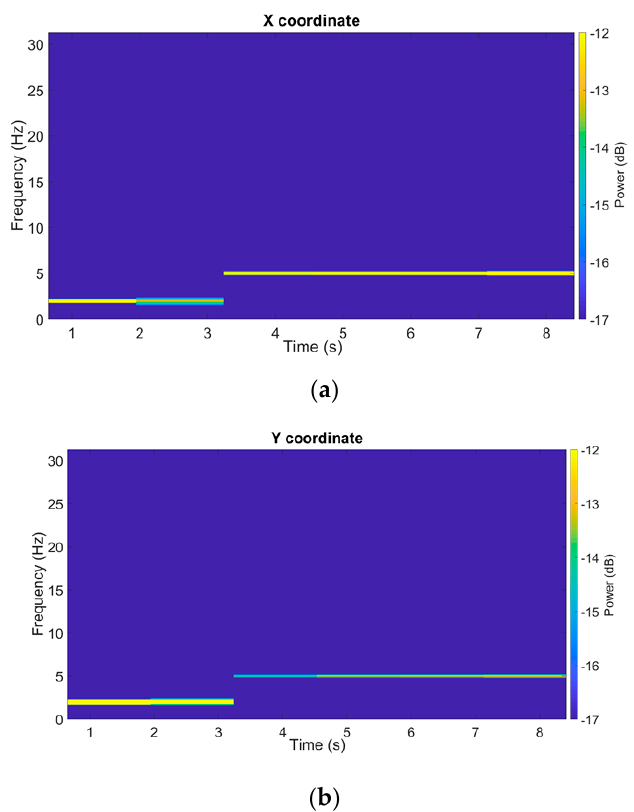
Figure 8. Spectrograms of a filtered SM test trajectory (x and y coordinates).